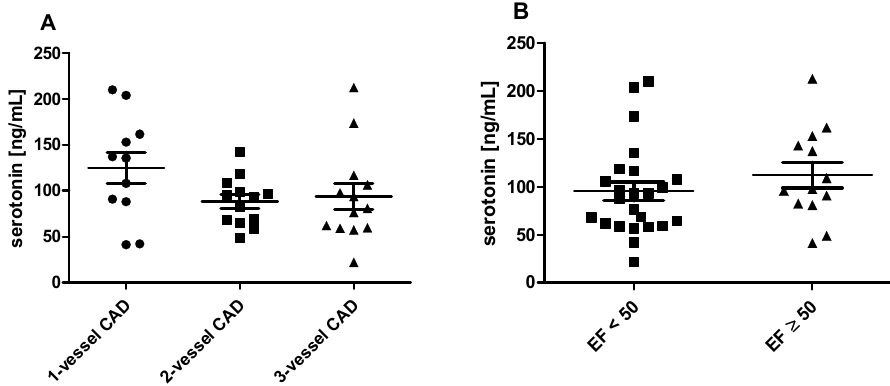
Figure 4. Neither the type of coronary artery disease (CAD) ( A ) nor the left ventricular ejection fraction ( B ) determined by echocardiography were associated with alterations in serum serotonin levels.